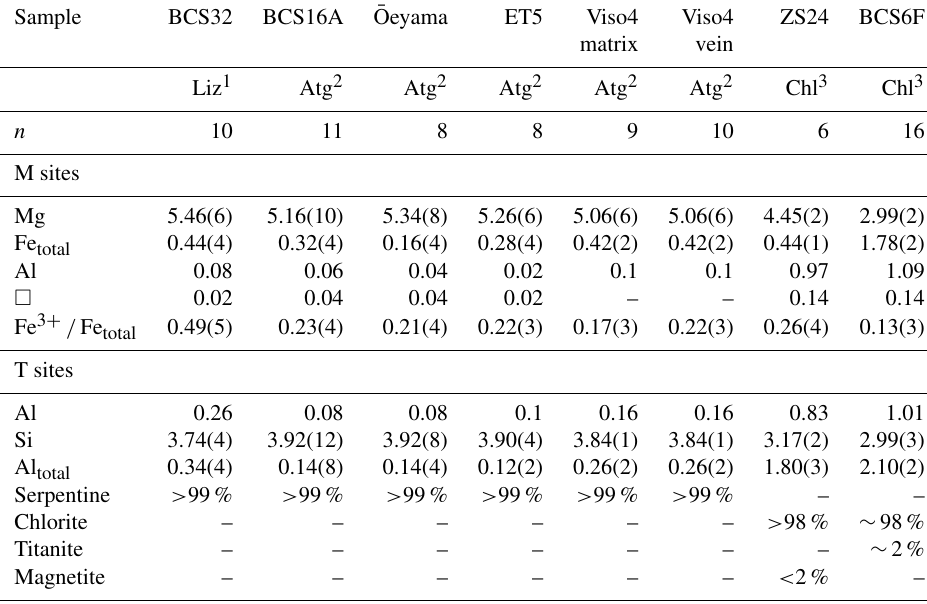
Table 1. Chemical composition and mineralogical mode of samples analyzed by Mössbauer spectroscopy. Sample